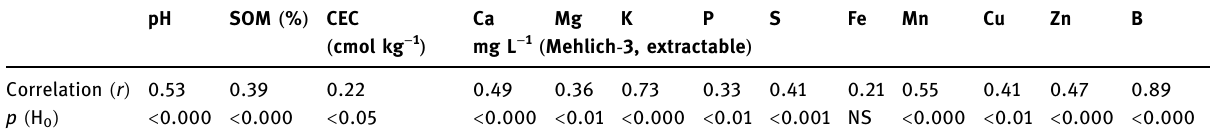
Table 4: Correlation between the topsoil and subsoil parameters. Topsoil and subsoil data from all 3 years were included in the analysis. pH SOM ( % ) CEC Ca Mg K P S Fe Mn Cu Zn B ( cmol kg − 1 ) mg L − 1 ( Mehlich - 3, extractable ) Correlation ( r )